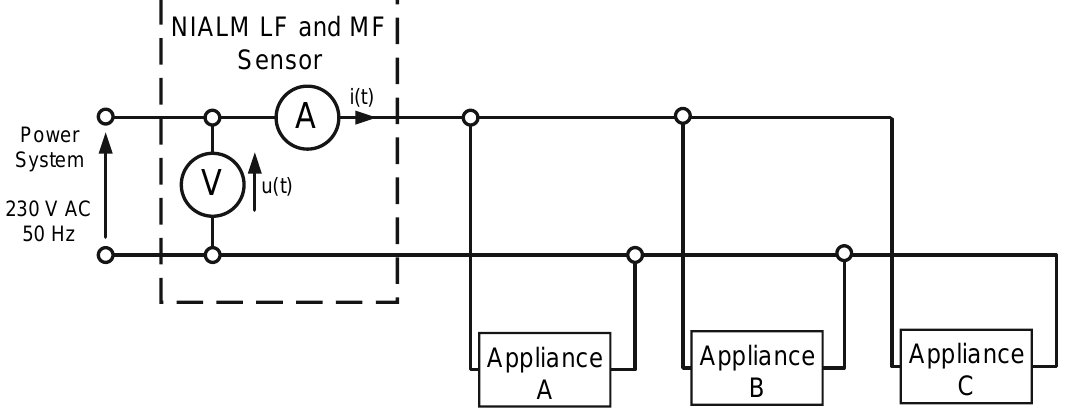
Figure 3. Block diagram of the measurement setup.